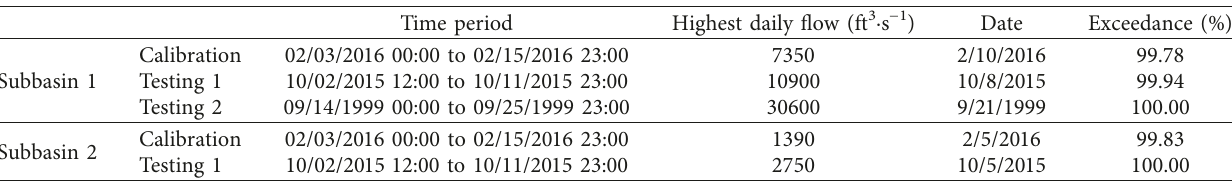
Table 2: Calibration and testing time periods and associated flow statistics of two subbasins in the Waccamaw